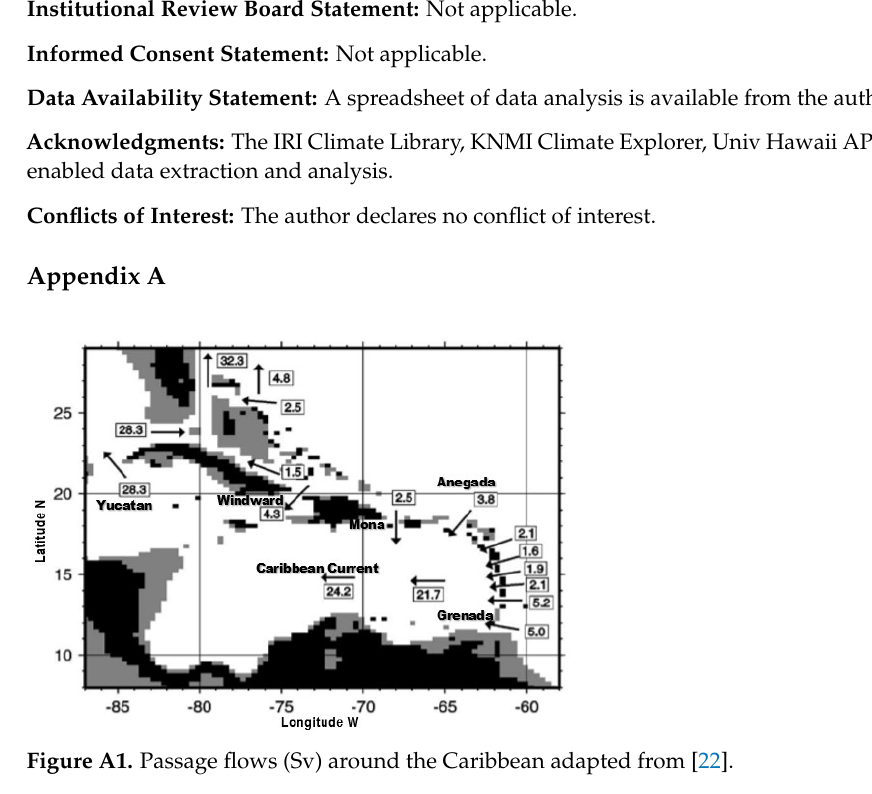
Figure A2. Intercomparison of monthly 50–100 m meridional currents averaged over the AMW in- dex area (15–22° N, 78–61° W), a validation that offers context. ORA5 and GODAS are ECMWF and NCEP ocean reanalyses, respectively. Here, Atlantic inflow to the Caribbean is –V. References 1.